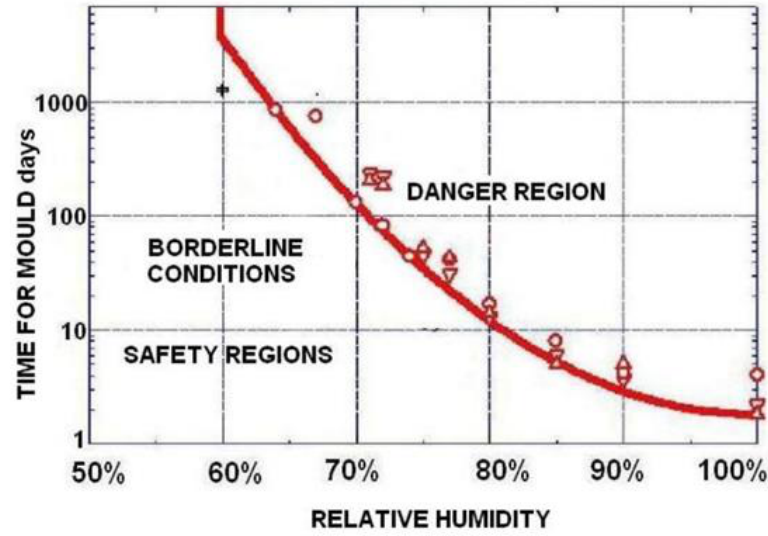
Figure 1. Time for mold formation according to relative humidity. Source: [23].